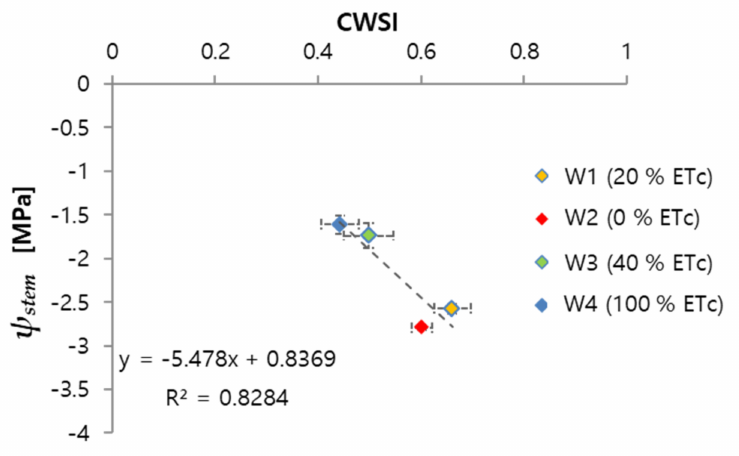
Figure 4. Relationship between midday stem water potential and adaptive CWSI at 12 h.